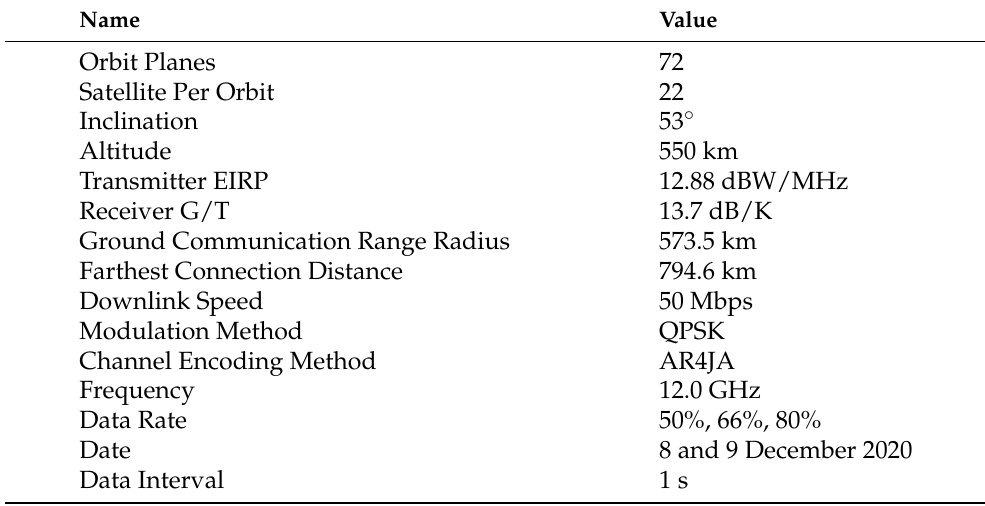
Figure 4. The scene is modeled by Starlink, where the lines represent satellite-to-ground connections. Table 2. Parameters in the scenario